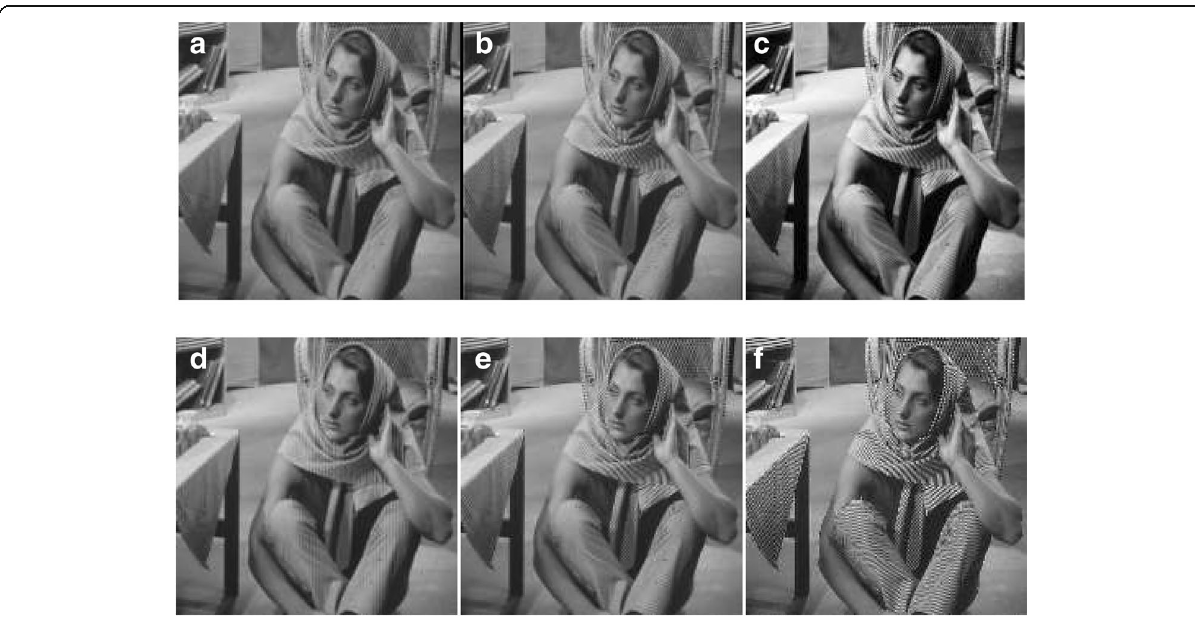
Fig. 5 Enhancement results of Barbara. a Original image b DSBP c Fuzzy_INT d NSCT e NSST f